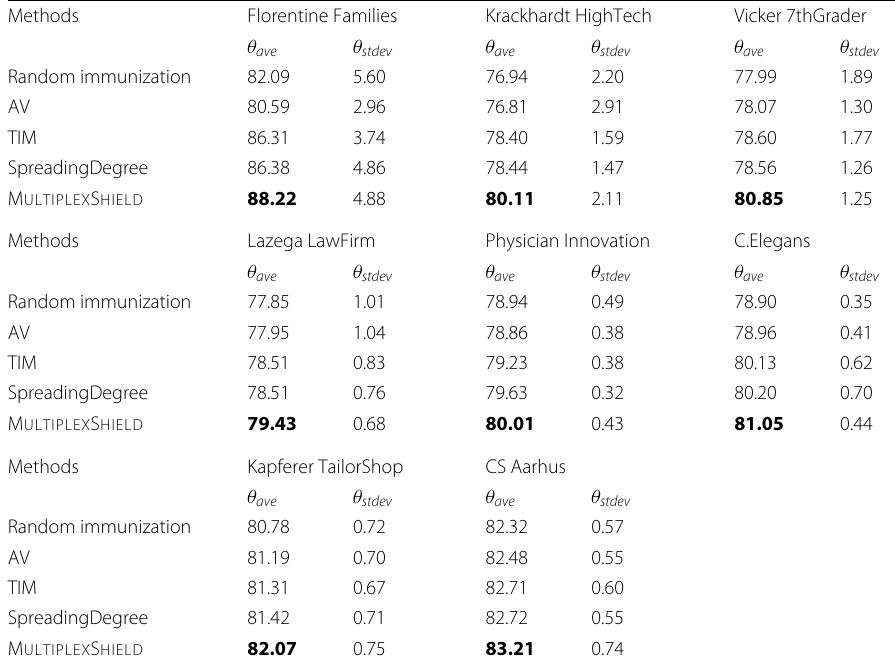
Table 3 Multiplex-based protection scheme, random nodes attack scenario Methods